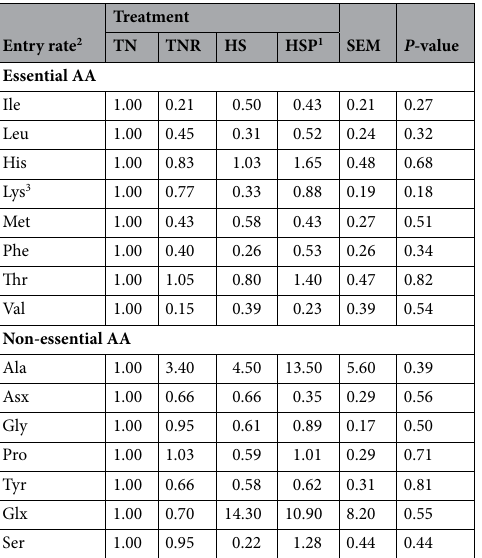
Table 4. Effects of feed restriction, heat stress, and heat stress with supplementation of a postbiotic on relative entry rates of plasma amino acid (n = 4 per treatment). TN thermoneutral, TNR thermoneutral feed-restricted, HS heat stress, HSP heat stress-postbiotic, SEM standard error of the mean. 1 AO postbiotic fed at 3 g/calf/day and mixed with milk replacer. 2 Plasma AA entry rates in TNR, HS, and HSP were expressed relative to TN treatment. 3 Plasma Lys entry rate tended ( P = 0.07) to decrease more in HS compared with HSP